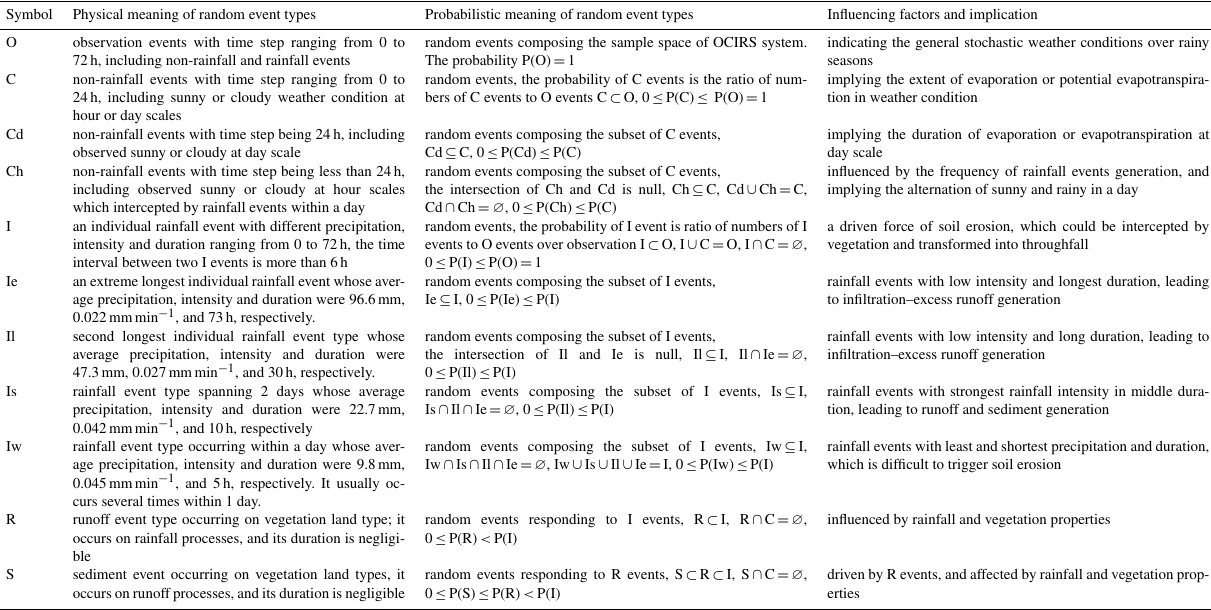
Table 2. Definition and explanation of all random events in